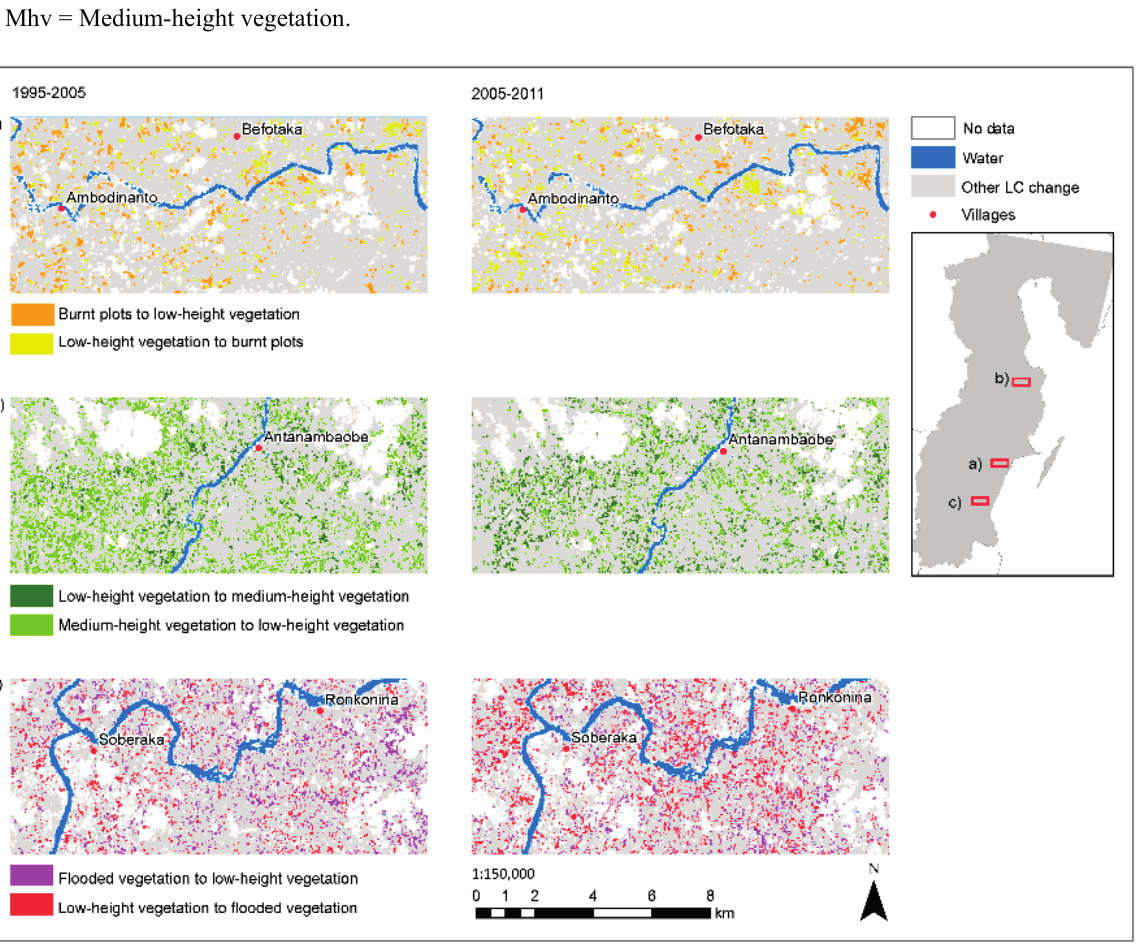
Figure 3. The most dominant LC transitions during both intervals: ( a ) between burnt plots and low-height vegetation; ( b ) between low-height and medium-height vegetation; ( c ) between flooded and low-height